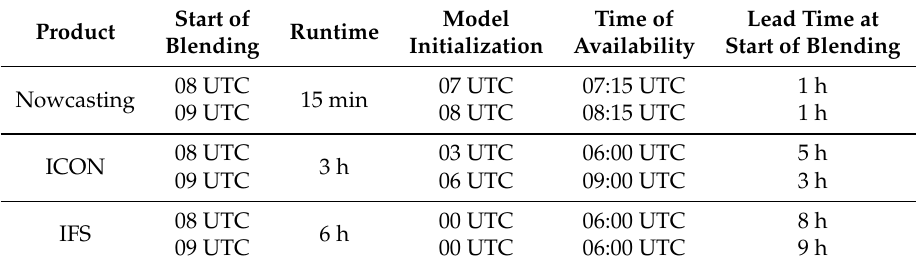
Table 2. Two exemplary cases (08 and 09 UTC) for the temporal availability of the utilized forecasts for a blending. Depending on the start of the blending the lead time of the forecasts can